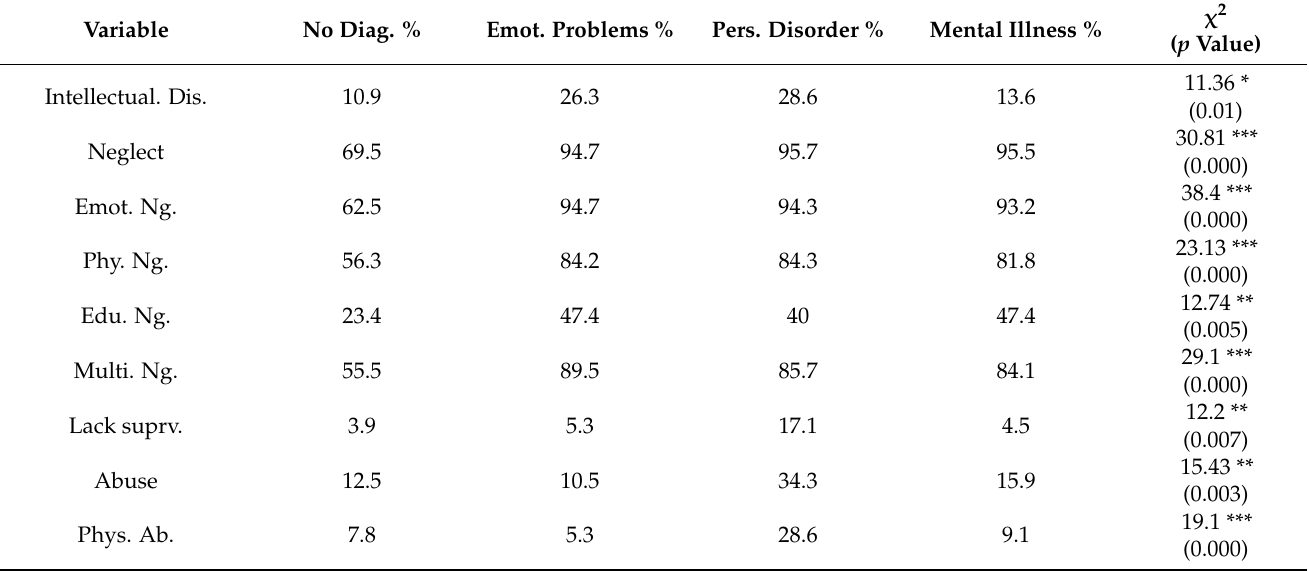
Table 3. Associations between Mothers’ Mental Health Diagnoses and Child Maltreatment.